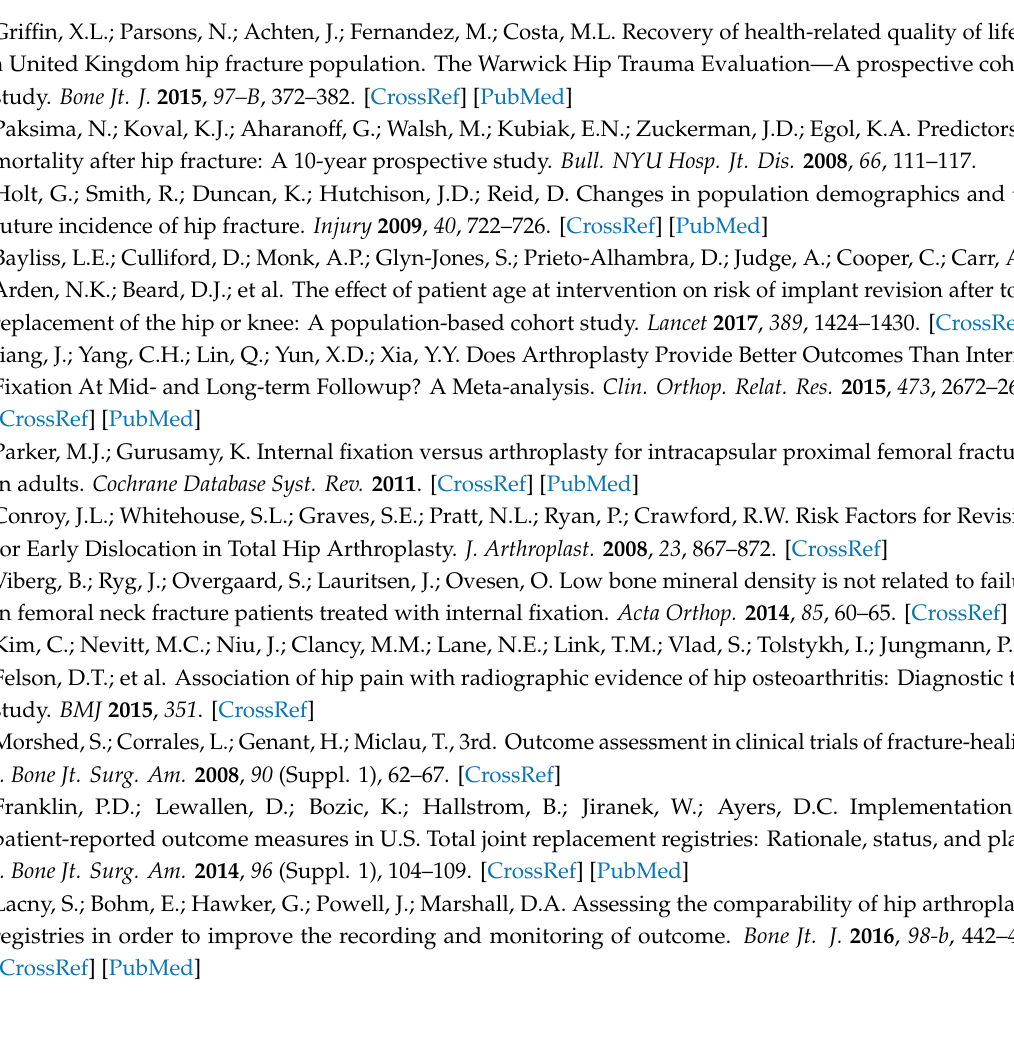
Table S1. Profile of patients with incomplete six-month follow up data; Table S2: (A) Univariable associations with future revision arthroplasty or conversion to arthroplasty (Included participants with date of injury 2009 onwards, n = 2028); Table S2: (B) Factors associated with future revision arthroplasty or conversion to arthroplasty, adjusted for confounding (Included participants with date of injury 2009 onwards, no covariates missing (n =